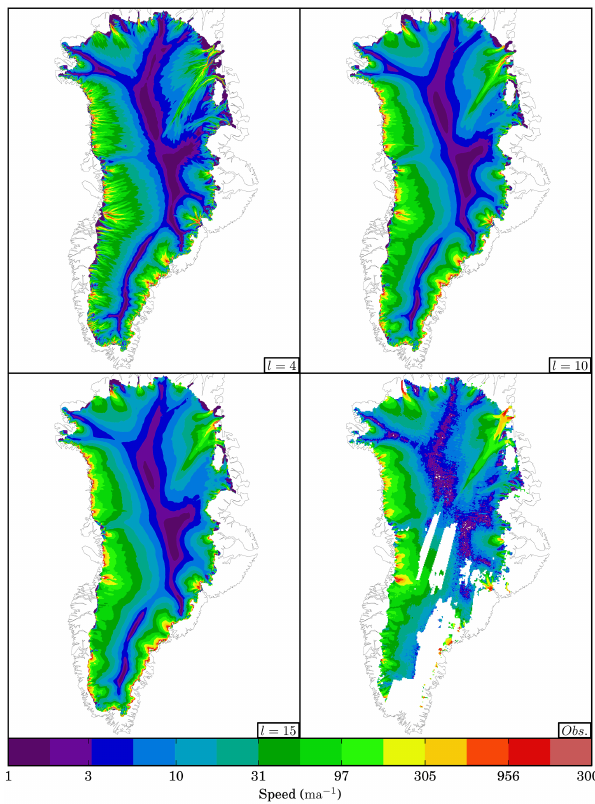
Figure 2. Balance velocity solution for a mesh size of h = H and l ∈ { 4 , 10 , 15 } as well as InSAR surface